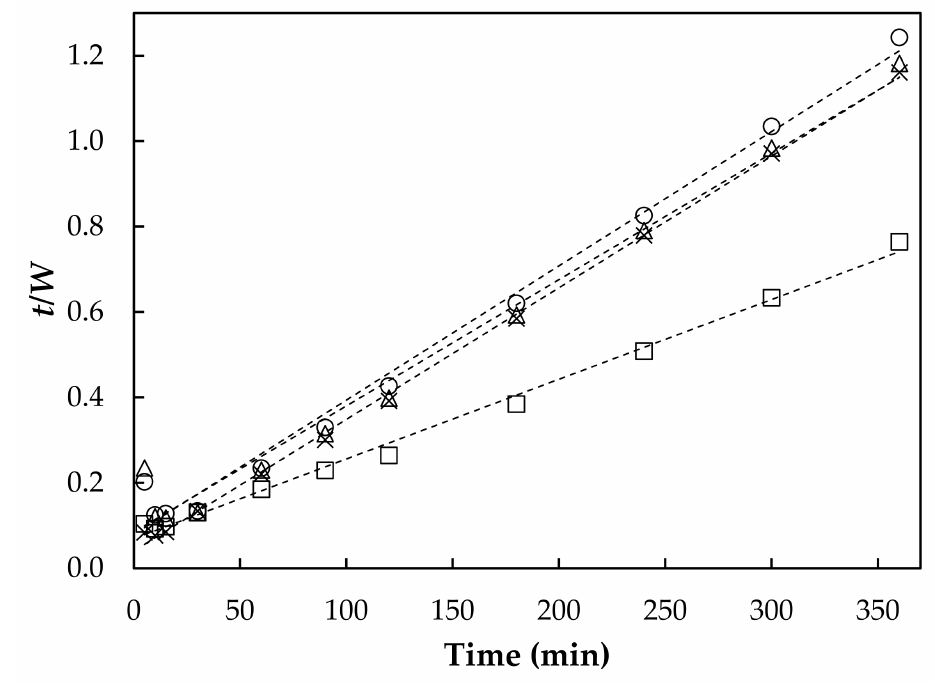
Figure 2. Swelling rate curves of AHR0 ( × ), AHR3 ( (cid:3) ), AHR5 ( ∆ ), and AHR10 (